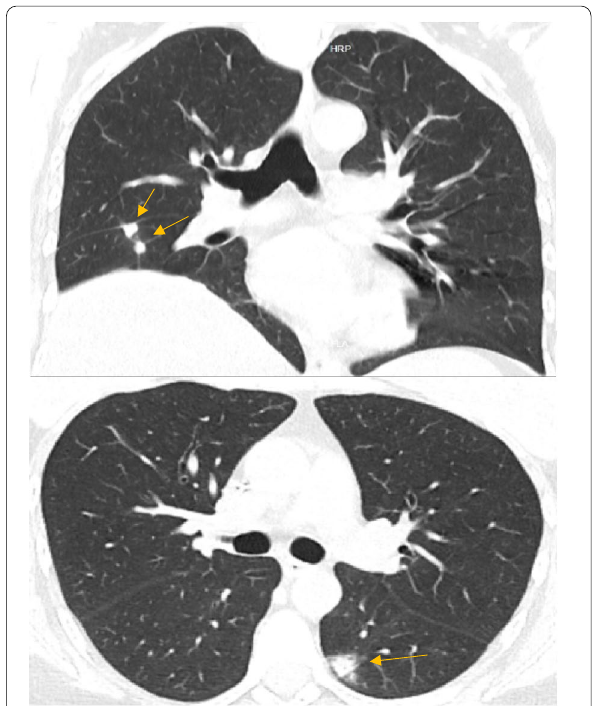
Fig. 1 High resolution chest computed tomography showing bilateral solid nodules with ground glass halo (arrows). Source: